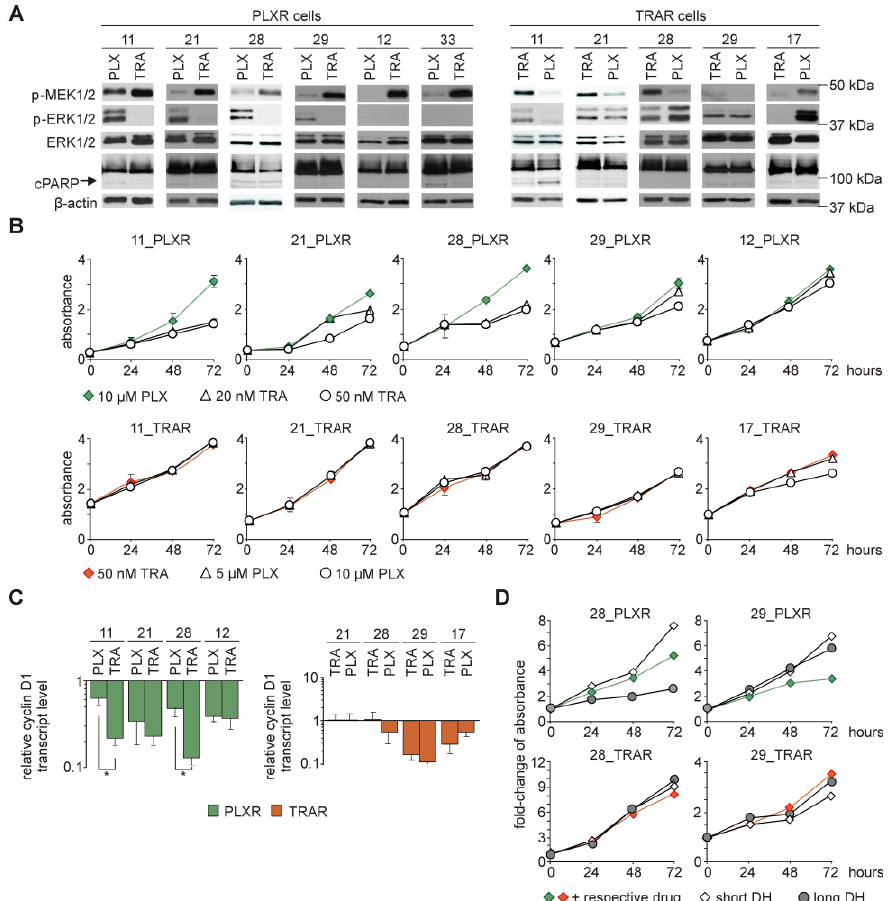
Figure 5. A remarkable plasticity of resistant melanoma cells shown as phenotypic reprogramming accompanying development of cross-resistance. Vemurafenib-resistant (PLXR) cells were shortly exposed to trametinib (TRA), whereas trametinib-resistant cells (TRAR) to vemurafenib (PLX) at indicated concentrations. ( A ) Representative immunoblots showing levels of phosphorylated MEK1 / 2 (p-MEK1 / 2) and ERK1 / 2 (p-ERK1 / 2), and cleaved PARP (cPARP) after 19 h of treatment with a corresponding drug. β -actin was used as a loading control. ( B ) Proliferation curves of PLXR and TRAR cell lines grown in the presence of di ff erent concentrations of complementary drugs were obtained based on activity of acid phosphatase. Representative results of an experiment performed in triplicate are shown. ( C ) Cyclin D1 transcript levels were assessed using qRT-PCR. They were expressed relative to their levels in drug-naïve cells cultured without drugs. Bars represent mean values of 3 biological replicates ± SD. Di ff erences are considered significant at * p < 0.05. ( D ) PLXR and TRAR cell lines were either exposed to the respective drug (10 µ M PLX or 50 nM TRA) or subjected to either short drug holiday (short DH) or drug holiday for 10 days (long DH). Fold-changes of absorbance values at di ff erent time points (24 h, 48 h, 72 h) were calculated relative to absorbance value at the starting point of the APA assay (0 h). Representative results of an experiment performed in triplicate are shown.